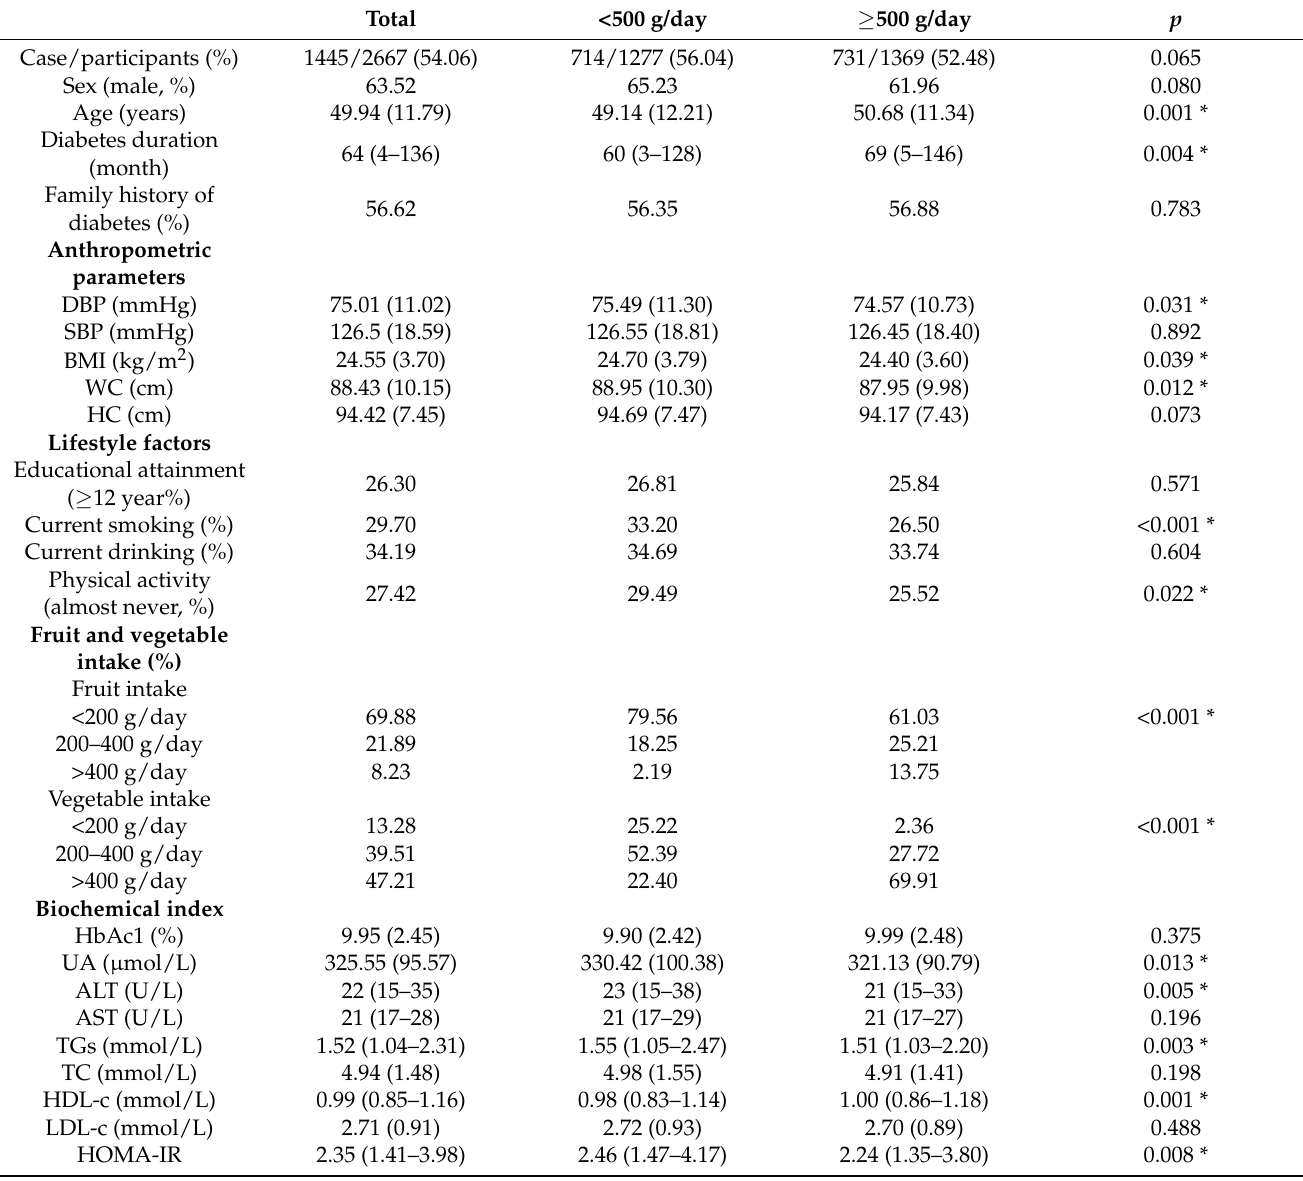
Table 1. Baseline characteristics of the participants according to their fruit–vegetable